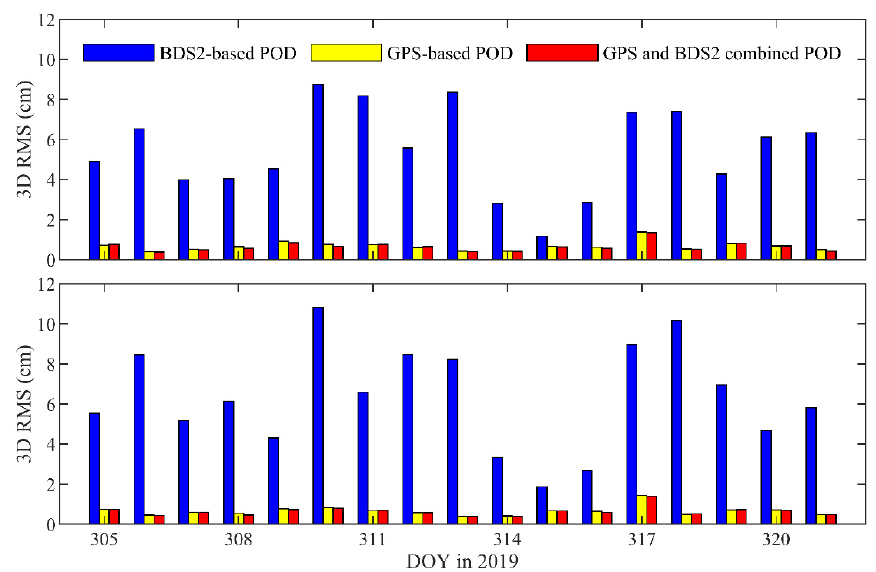
Figure 16. 3D RMS of overlap comparisons of BDS2 ‐ only, GPS ‐ only, and GC combined POD for TH ‐ 2A ( top panel ) and TH ‐ 2B ( bottom panel ).